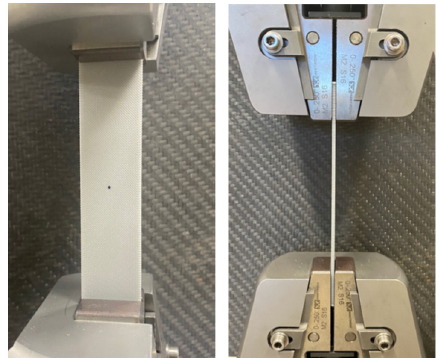
Figure 11. A rectangular test specimen with a hole held by the testing equipment.